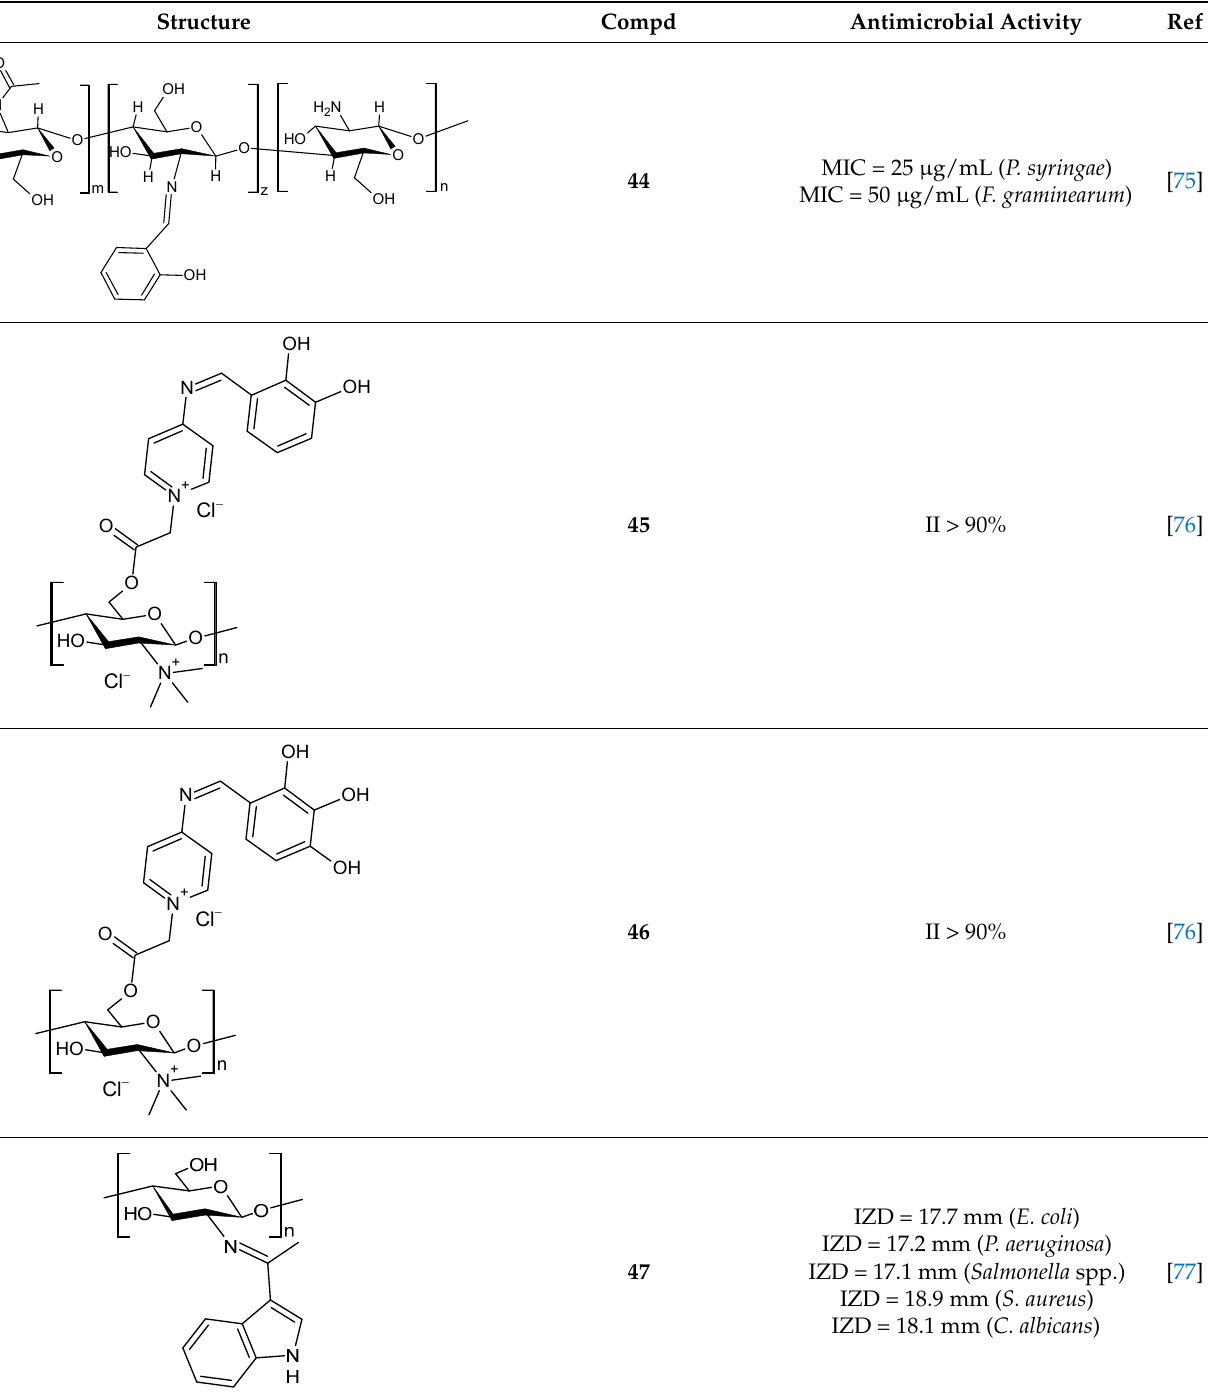
Table 3. Structure and antibacterial activity of chitosan-based Schiff bases. Structure